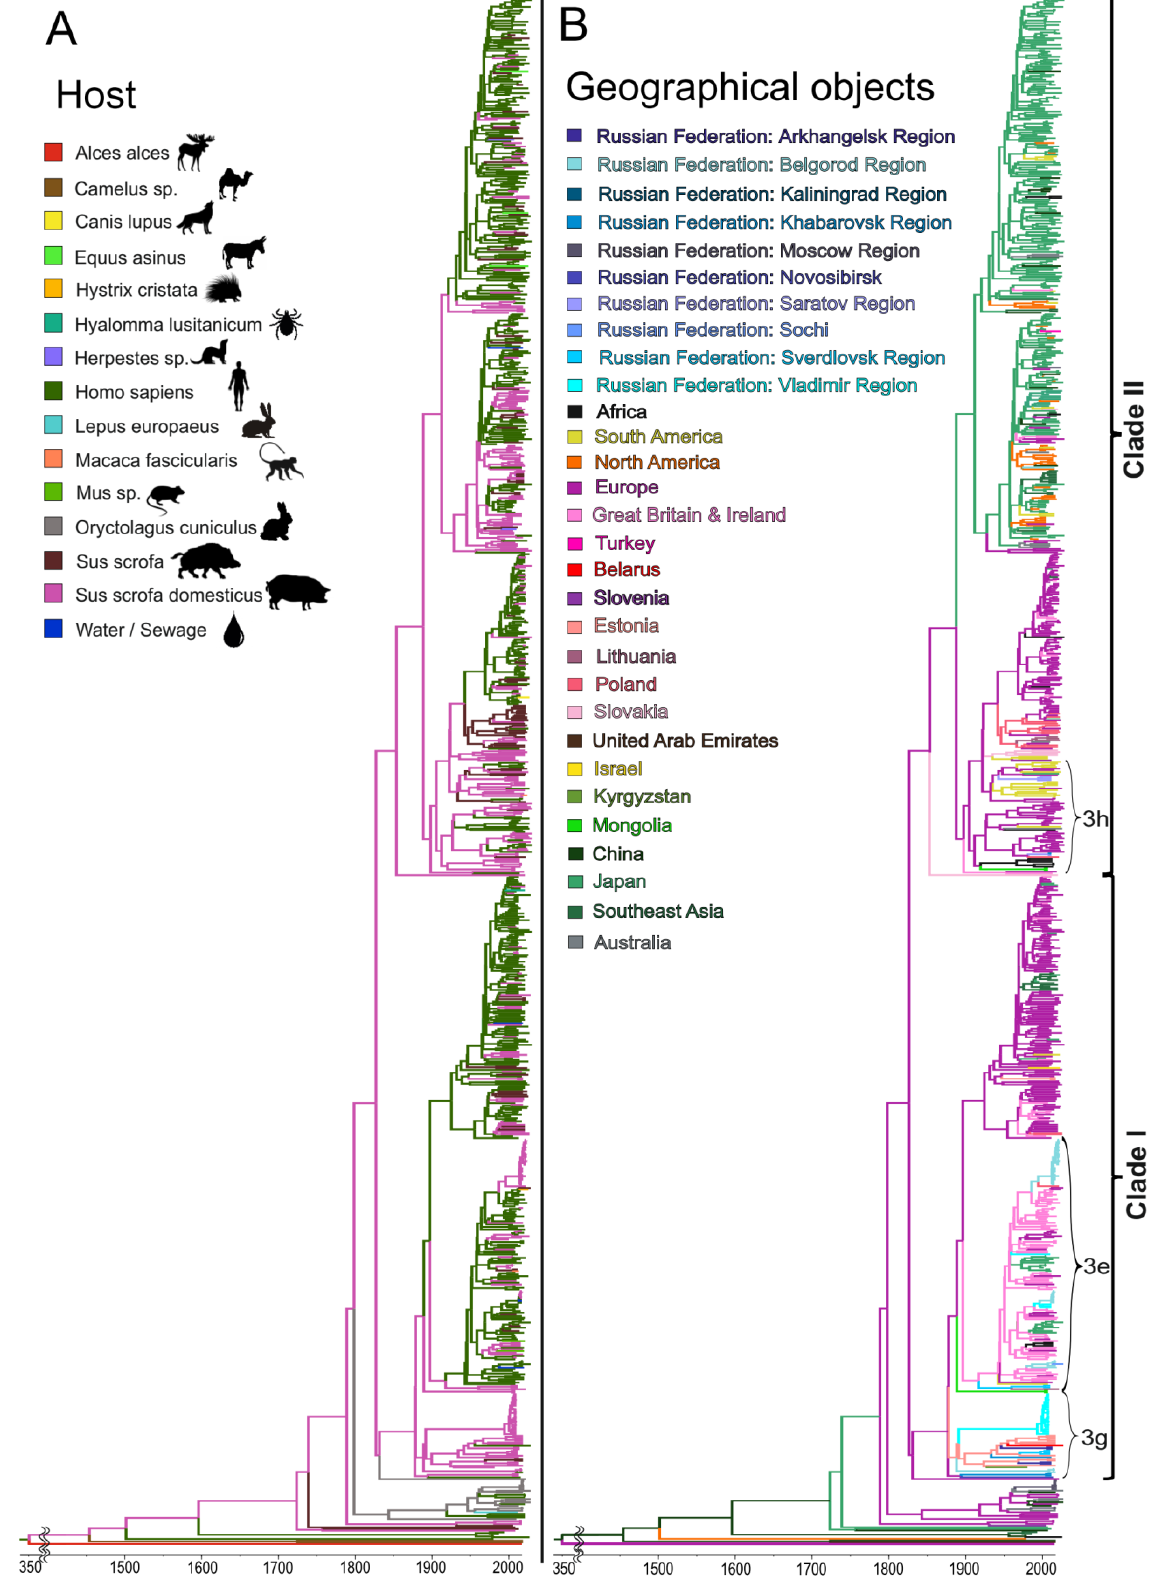
Figure 5. Bayesian phylogenetic tree based on 300 nt ORF-2 HEV sequences with indicated host range ( A ) and geographic region of origin ( B ). The tree root was cut off to ensure the visibility of the modern parts of the tree. The X-axis shows chronological time expressed in years.